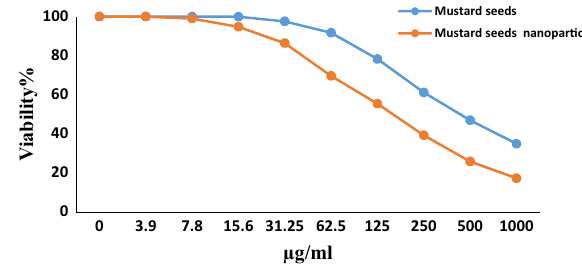
Figure 5: Evaluation of cytotoxicity of mustard seed and its nano - formulation against HepG -